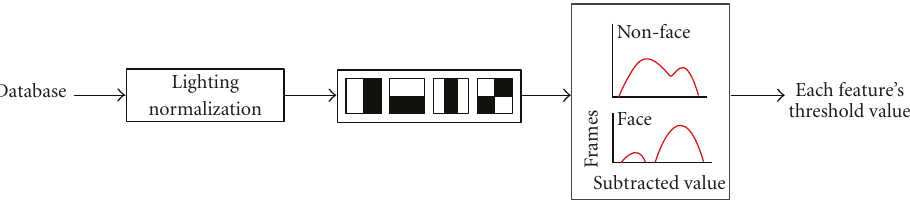
Figure 7: The process in selecting the threshold value for features in each rectangle.